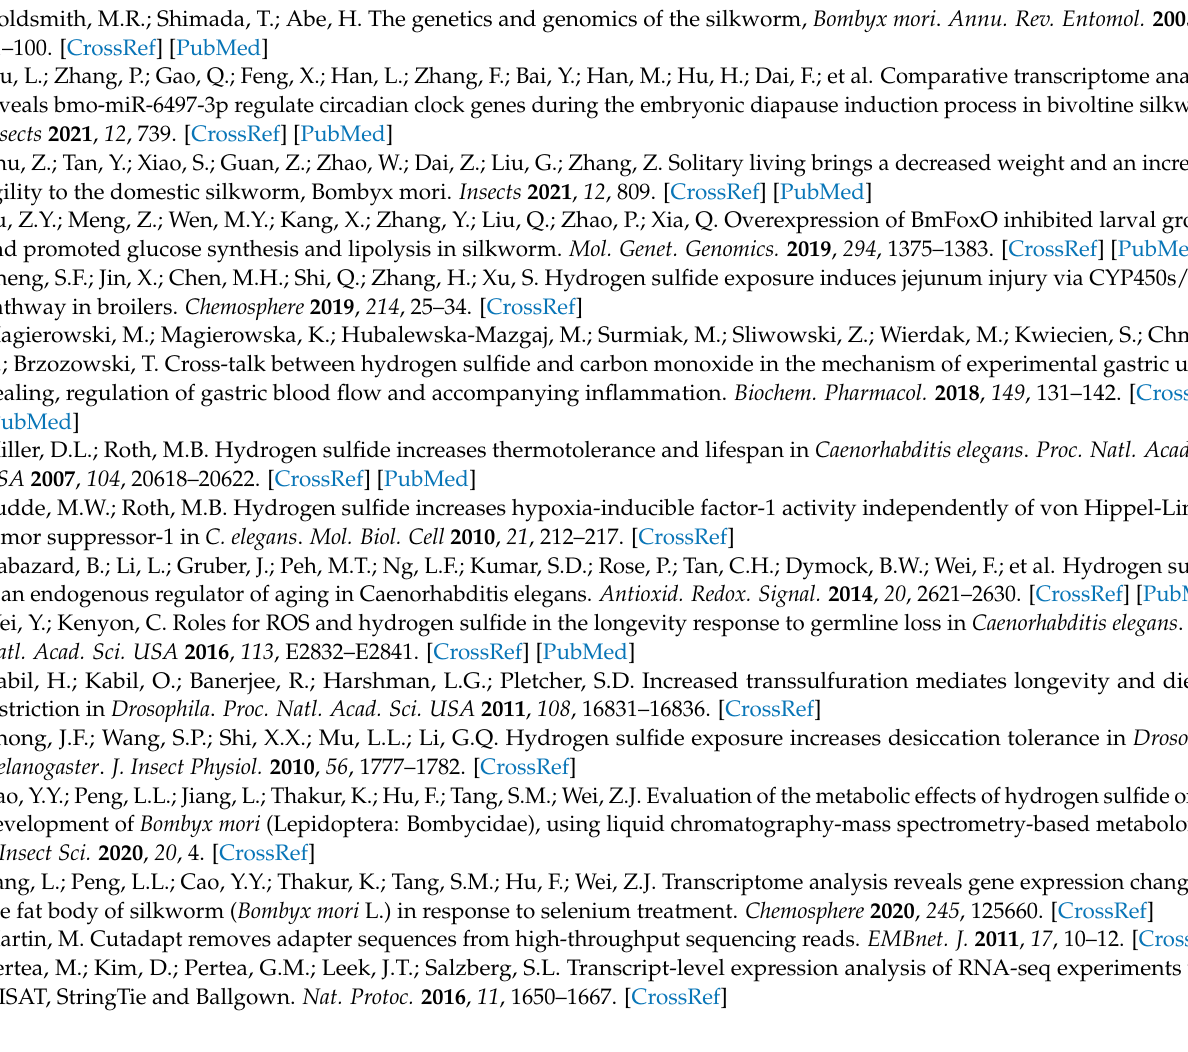
analysis. Table S2. Statistical analysis of the RNAs Libraries. Table S3. Distribution of gene expression levels between H 2 S-treated and the control group and the partial DEGs. Table S4. The list of DEGs comparison between H 2 S treated group and control group. Table S5. Analysis of the enriched GO terms. Table S6. Analysis of the enriched KEGG